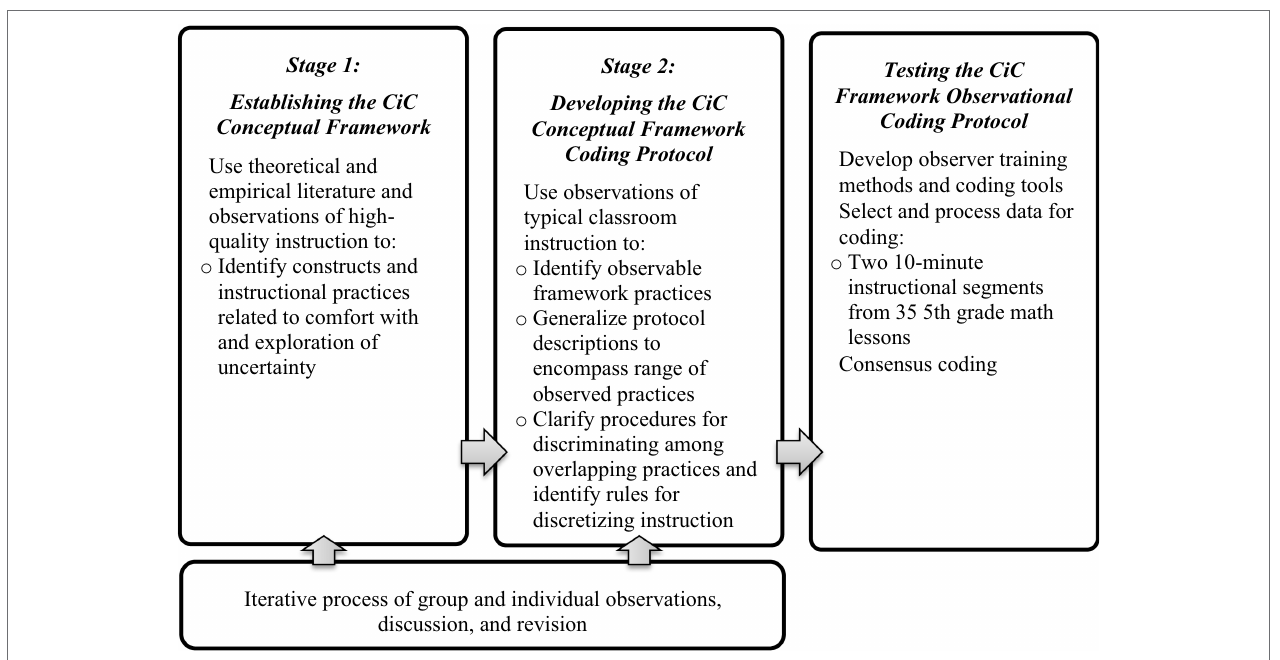
FIGURE 1 | Overview of the CiC framework and protocol development